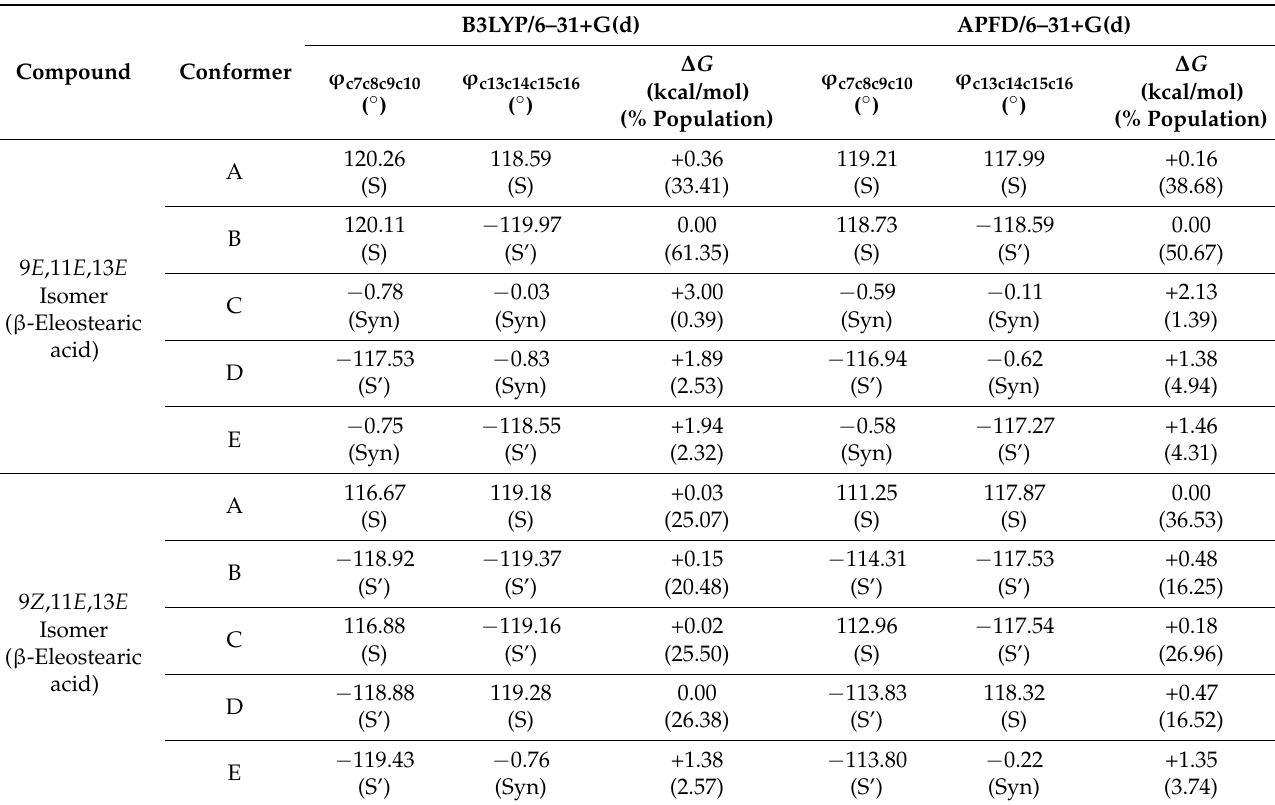
Table 2. Conformational properties, ∆ G values (kcal · mol − 1 ), and % populations of various low-energy conformers of the 9,11,13-conjugated fatty acid and 10,12,14-conjugated hexadecatrienyl acetate geometric isomers with geometry optimization at the B3LYP/6–31+G(d) and APFD/6–31+G(d) levels.